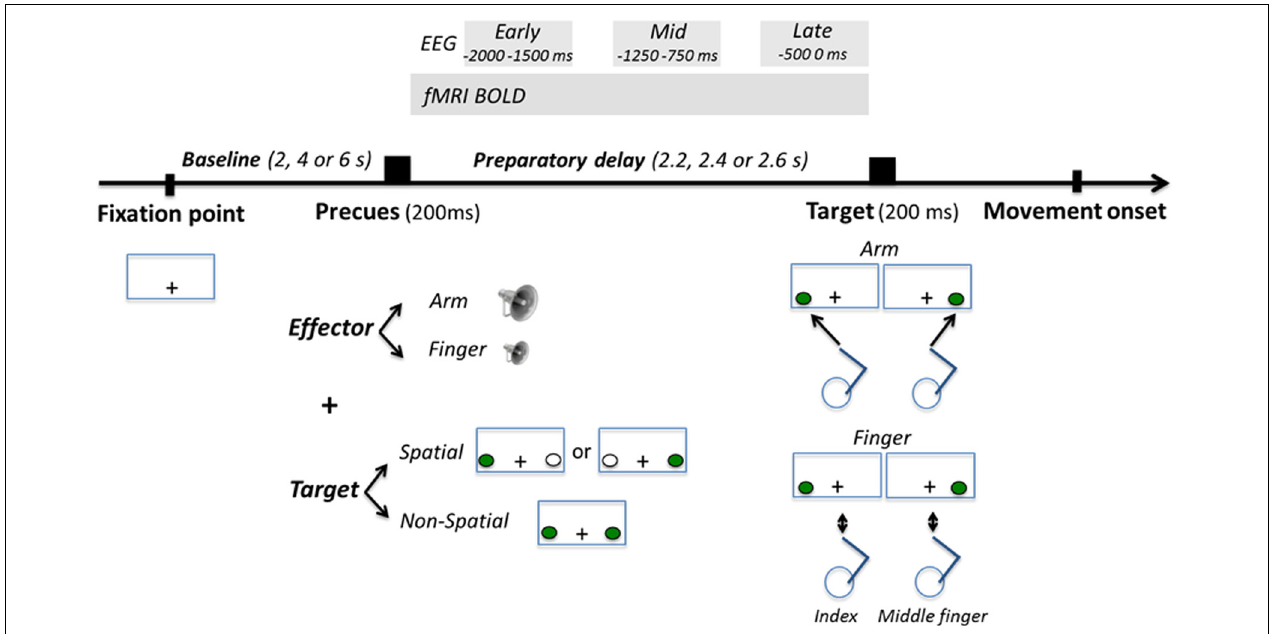
FIGURE 1 | Task description. Participants’ task was to respond as fast and accurately as possible to the appearance of a visuospatial target presented left or right of gaze, either by producing a right arm reaching movement toward it, or by producing a finger movement with their right index or middle finger depending on the laterality of the target (left target = index; right target = middle finger). Participants were precued as to the effector to be used with an auditory tone (high or low pitch for arm or finger, respectively) presented 2.2, 2.4, or 2.6 s prior to target onset. At the same time, participants were also precued as to the position of the upcoming target. In the Spatial condition, the left or the right target was presented in green for 200 ms, giving participants advance knowledge as to the position of the upcoming target. In the Non-Spatial condition, both targets were presented in green for 200 ms, giving participants no advance knowledge as to the position of the upcoming target. Neural activity during the preparatory delay was measured with BOLD and electroencephalography (EEG).